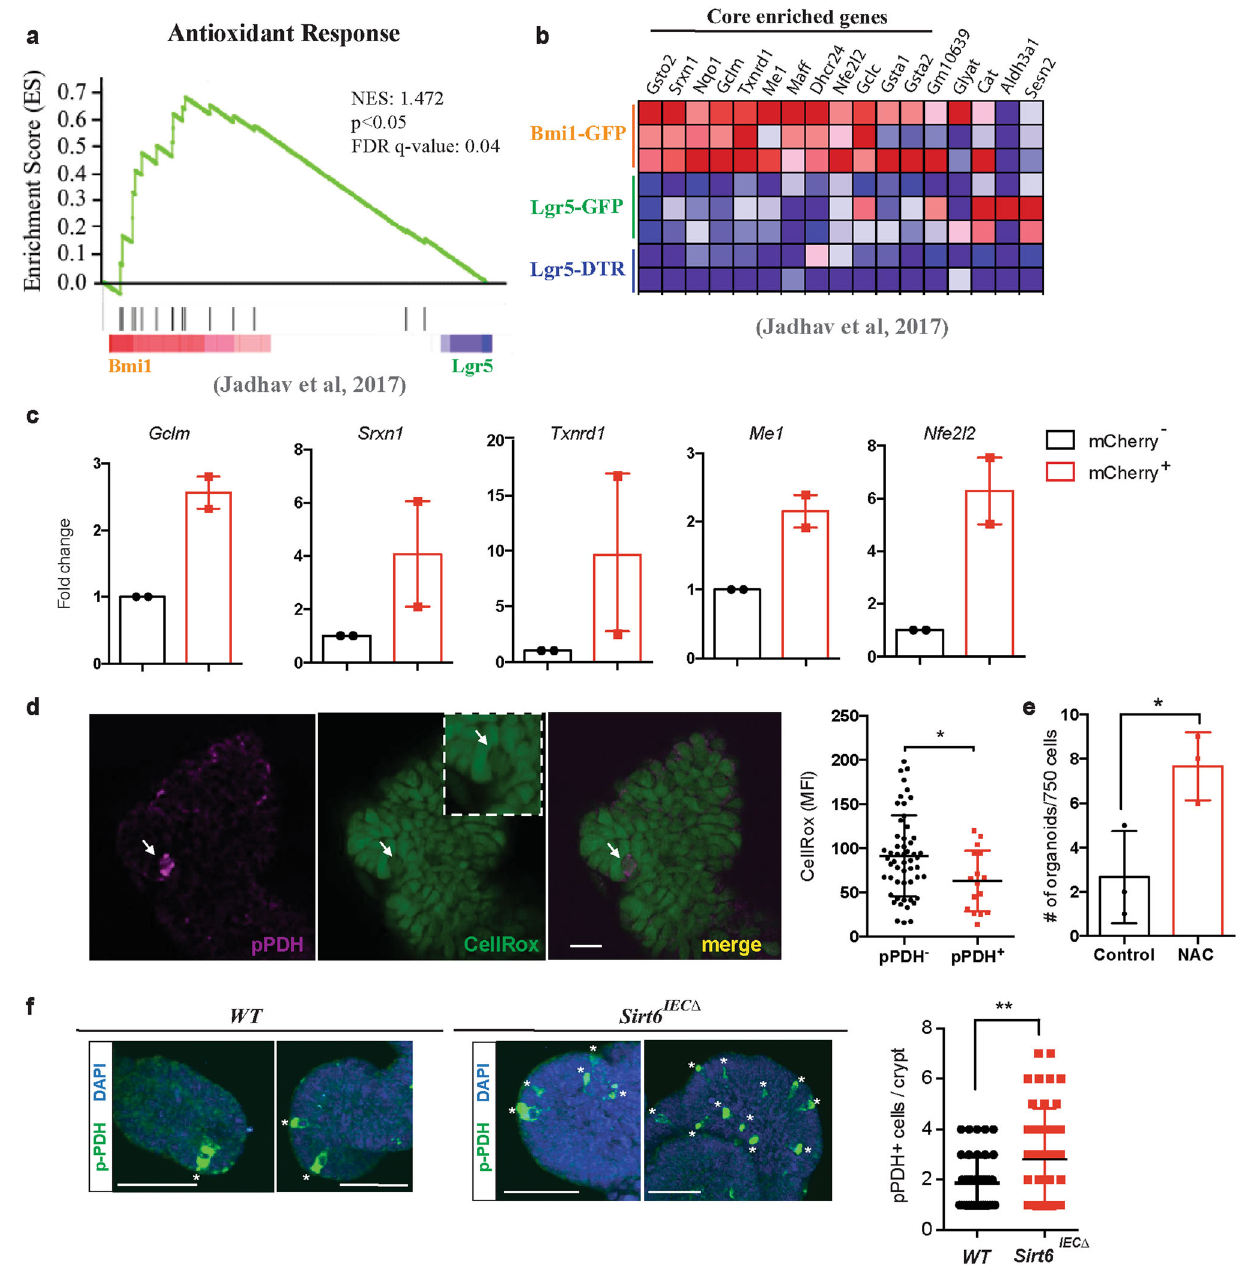
Fig. 5 Increased antioxidant response in pPDH + cells. a Gene set enrichment analysis of antioxidant genes in Bmi1-GFP cells compared to Lgr5 ISCs from Lgr5-GFP and Lgr5-DTR mice (Jadhav et al. 20 ) (nominal p value = 0.013). b Heat map of the antioxidant gene signature from (a) showing the core enriched genes. c qPCR analysis showing RNA expression of indicated genes on mCherry sorted cells from two APC min -Pdk1-mCherry organoid lines ( n = 2).